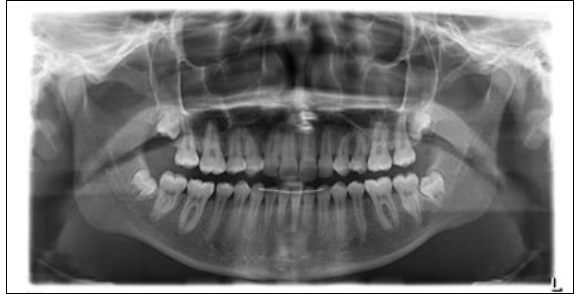
Figure 16. Lateral cephalogram immediately following debonding and completion of active orthodontic treatment.